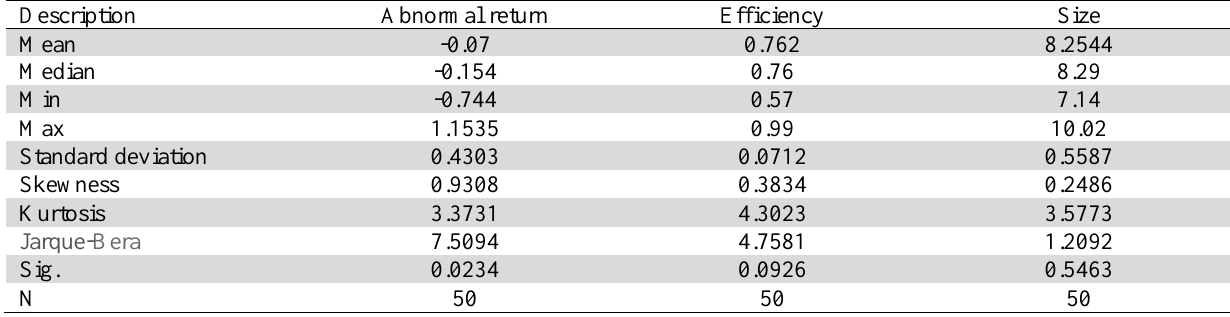
The summary of some basic